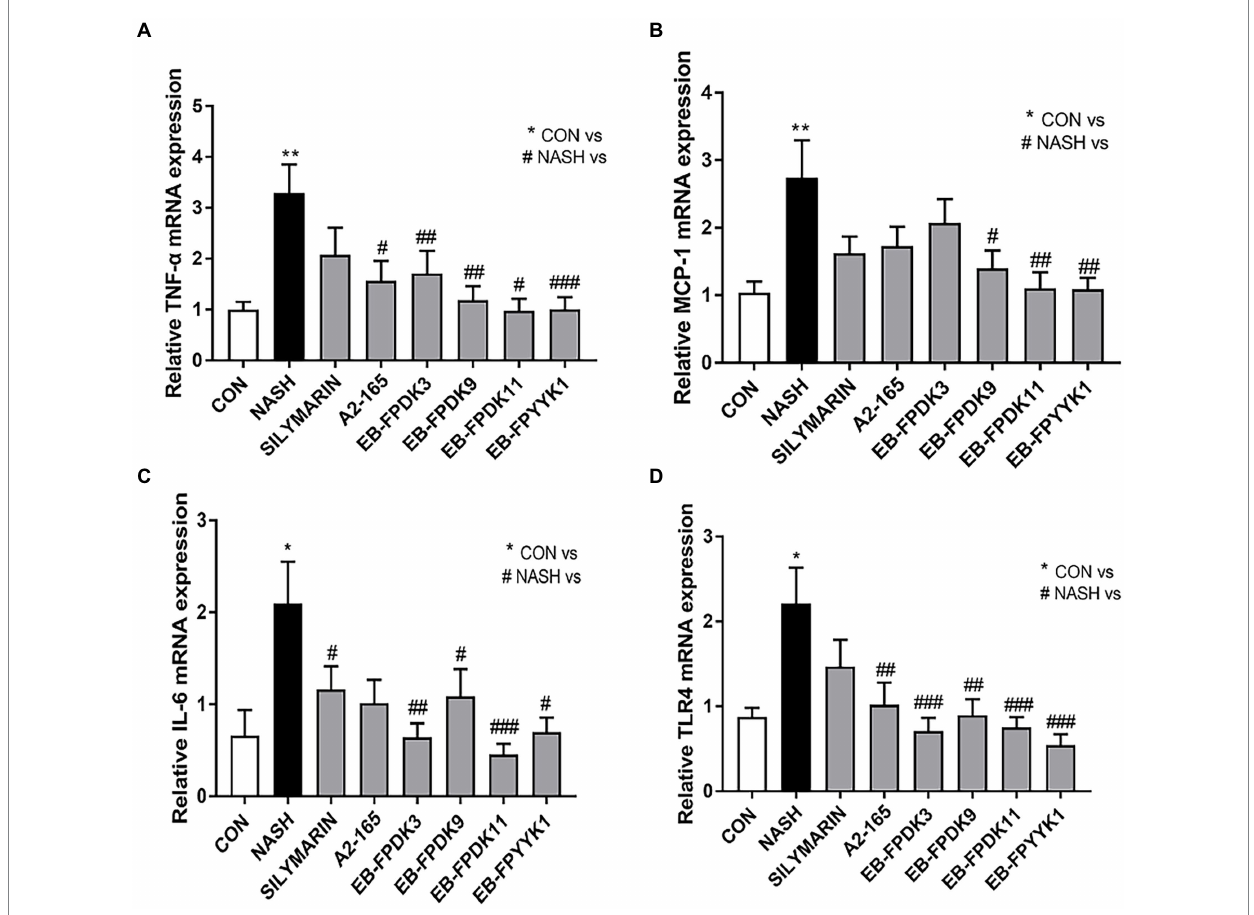
FIGURE 8 Faeclibacterium prausnitzii reduces the expression of inflammatory cytokines in the liver. mRNA levels of the inflammatory cytokines (A) TNF- α , (B) TLR4, (C) MCP-1, and (D) IL-6. Statistical analyzes were performed using Mann–Whitney U-test (two-tailed) (A,B) and Kruskal–Wallis one-way ANOVA with Dunn’s test (C,D) . ∗ p < 0.05, ∗∗ p < 0.01 versus the CON group; # p < 0.05, ## p < 0.01, ### p < 0.001 versus the NASH group. TNF- α , tumor necrosis factor- α ; TLR4, Toll-like receptor 4; MCP-1, monocyte chemoattractant protein-1; IL-6, interleukin-6; CON, control; NASH, nonalcoholic